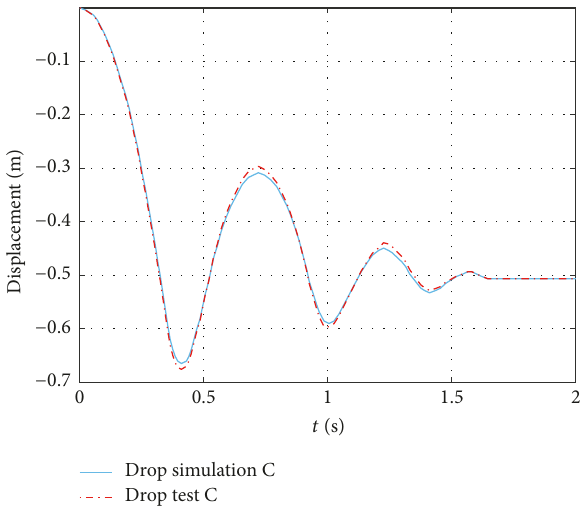
Figure 14: Comparison of results for drop analysis C.